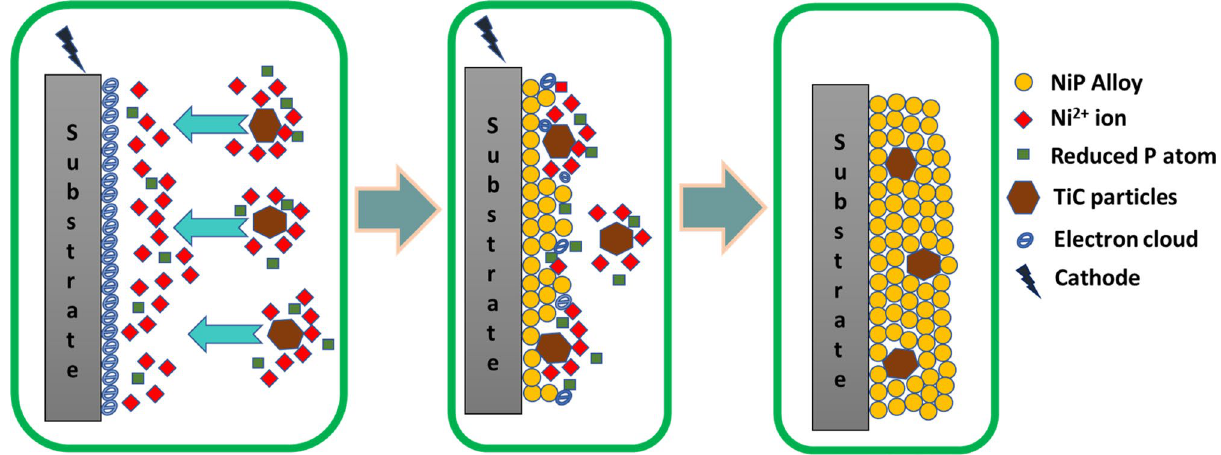
Figure 5. Schematic diagram for the co-deposition of TiC particles at the cathode (substrate) to form Ni–P– TiC composite